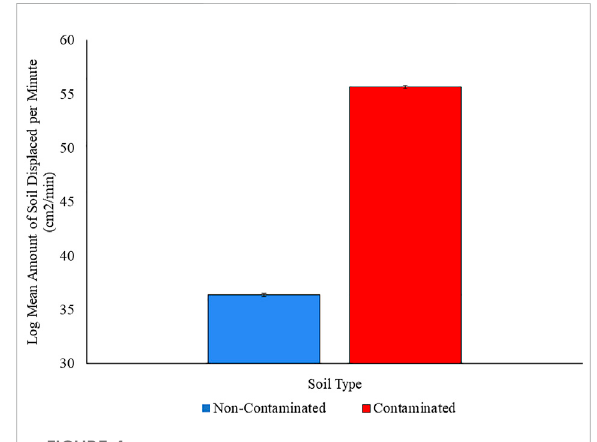
FIGURE 4 Log mean area of soil displaced by earthworms per minute in non-contaminated enclosures and enclosures contaminated with Roundup Ready-to-Use III. Error bars represent the standard error of the means; the standard error of the means is 0.04 for the non-contaminated treatment and 0.12 for the contaminated treatment. p <